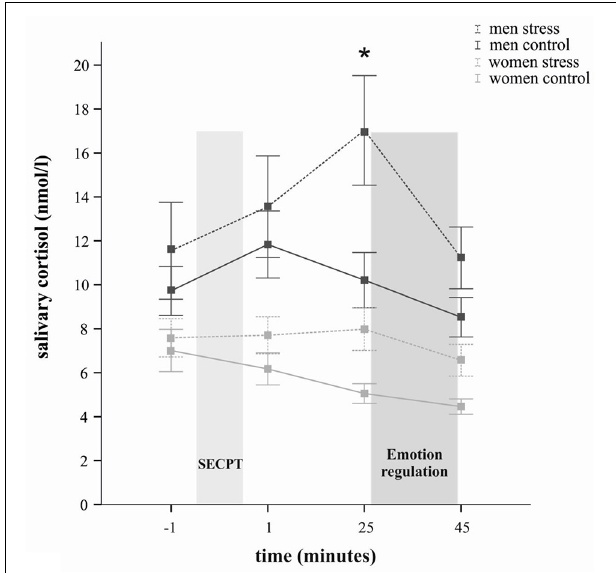
FIGURE 1 | Salivary cortisol in nanomoles per liter ( M ± s.e.m.) at several time points across the experiment. The lighter gray bar represents the time of the stress and control manipulation, respectively; the darker gray bar represents the time of the emotion regulation paradigm. Cortisol concentrations were significantly increased in the socially evaluated cold-pressor test (SECPT) groups but not in participants exposed to the warm water control condition. Men showed overall higher cortisol concentrations than women. In comparison to men from the control group, stressed men displayed significantly higher cortisol concentrations 25min after the stress manipulation ( ∗ p < 0 . 05; t -test). Similarly in comparison to women in the control group, stressed women displayed significantly higher cortisol concentrations 25min after stress manipulation ( ∗ p < 0 . 05; t